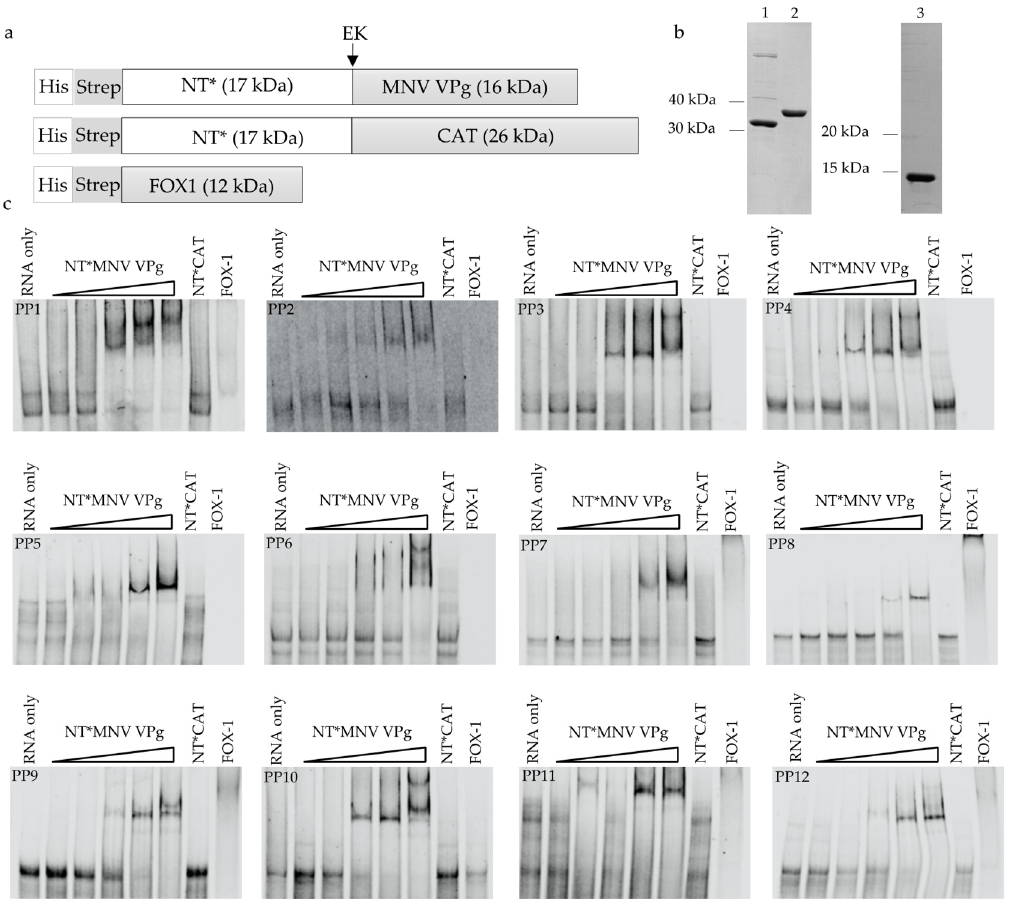
Figure 3. Binding of NT*MNV VPg to RNA pentaprobes . ( a ) Schematic of the NT*MNV VPg, NT*CAT and FOX-1 proteins used in RNA binding experiments. The construct contained a His 6 and Strep II affinity tag, the NT* fusion partner, and the protein to be expressed. An enterokinase cleavage site (EK) was included for cleavage and removal of the fusion partner. ( b ) Coomassie blue stained SDS-PAGE gel of purified protein (3 μ g) used for RNA binding experiments. 1; NT*MNV VPg, 2; NT*CAT, 3; FOX-1. ( c ) RNA EMSA of purified NT*MNV VPg incubated with 100 nM UTP ATTO 680 labelled pentaprobe RNA. The concentration of NT*MNV VPg was increased from 0.5 μ M to 8 μ M in 2-fold increments and is indicated by a gradient triangle from low concentration to high concentration. NT*CAT (8 μ M) and FOX-1 (8 μ M) were included as negative and positive controls, respectively.